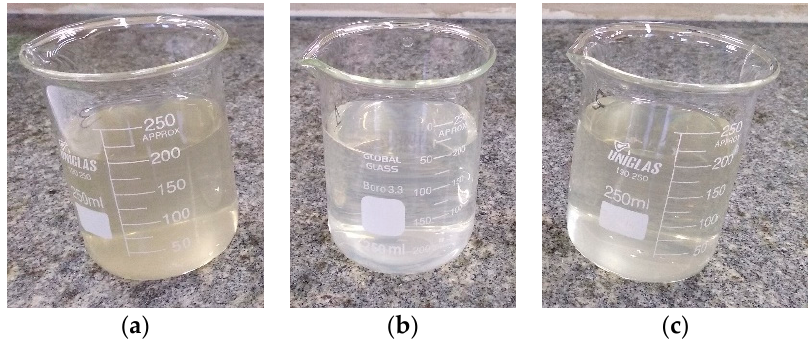
Figure 5. Stormwater appearance. (a) Runoff; (b) Model system A; (c) Model system B.